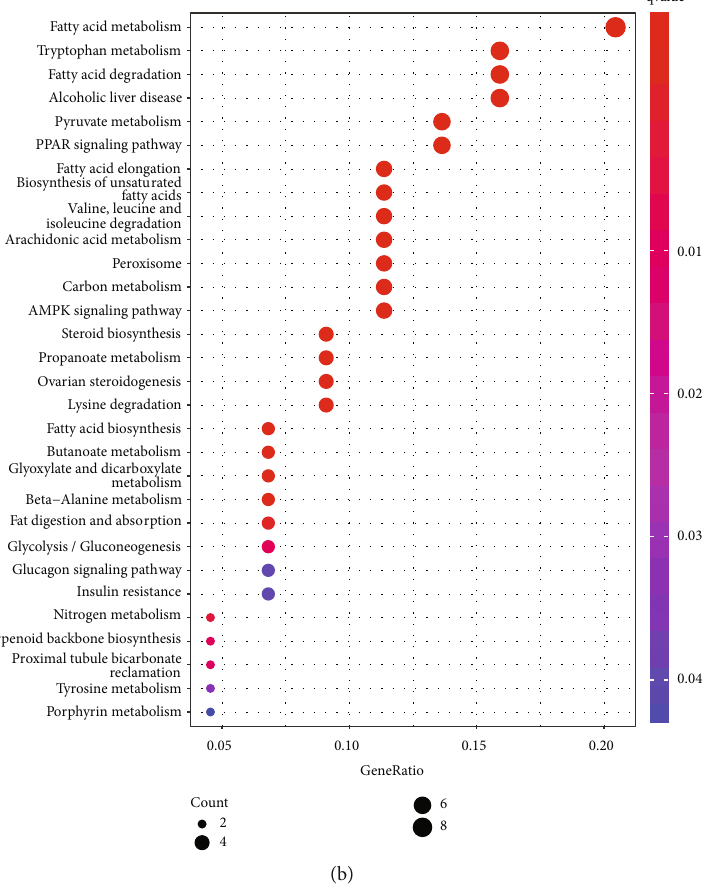
Figure 1: Functional enrichment analysis of the DEGs between CC specimens and nontumor specimens. (a) Distinctly enriched GO terms of DEGs in CC and (b) signi fi cant KEGG pathway terms of DEGs in